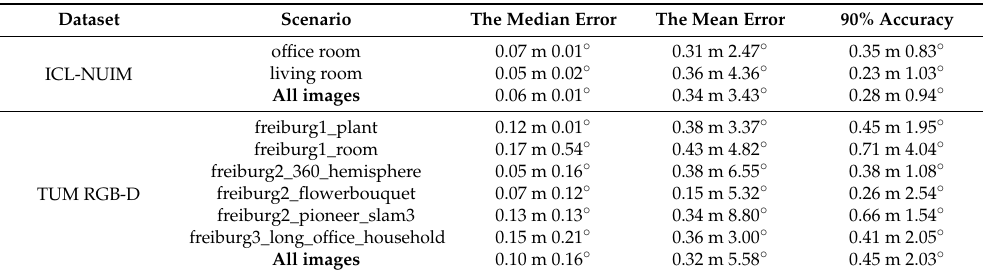
Figure 10. Cumulative distribution function of angle error. Table 4. Localization performance in different scenarios from different datasets.